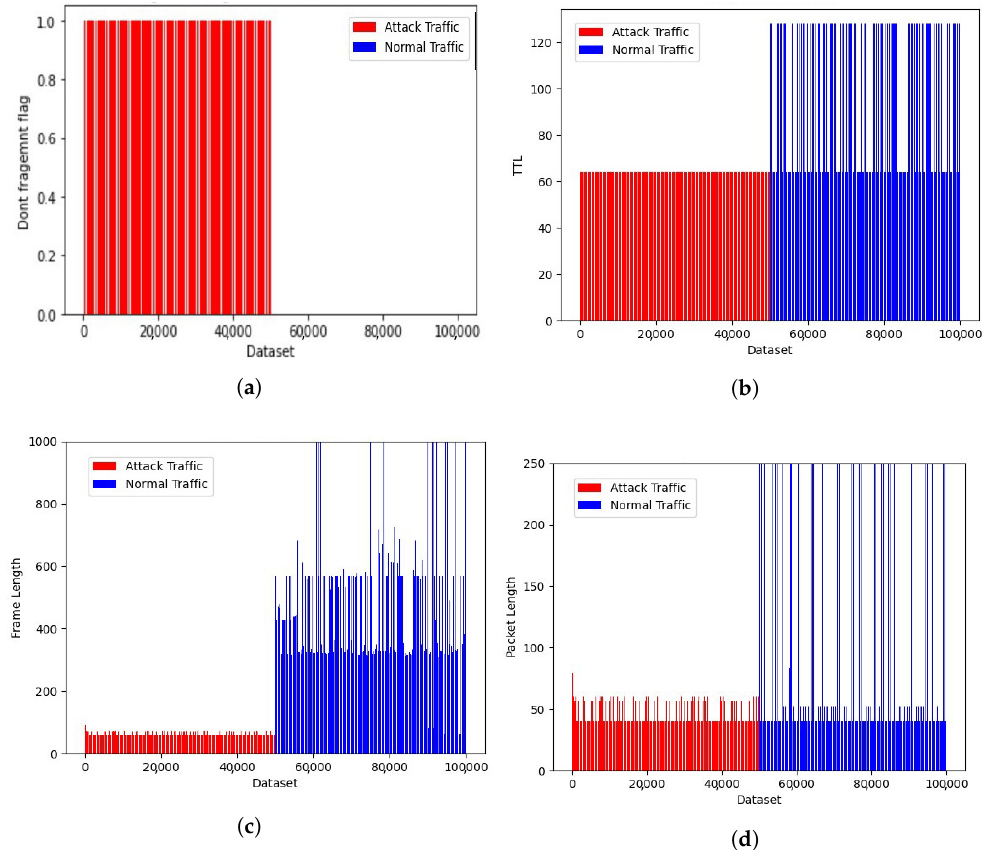
Figure 10. Dataset generated in the simulation environment representation: ( a ) Don’t Fragment flag; ( b ) time-to-live; ( c ) frame length; and ( d ) packet